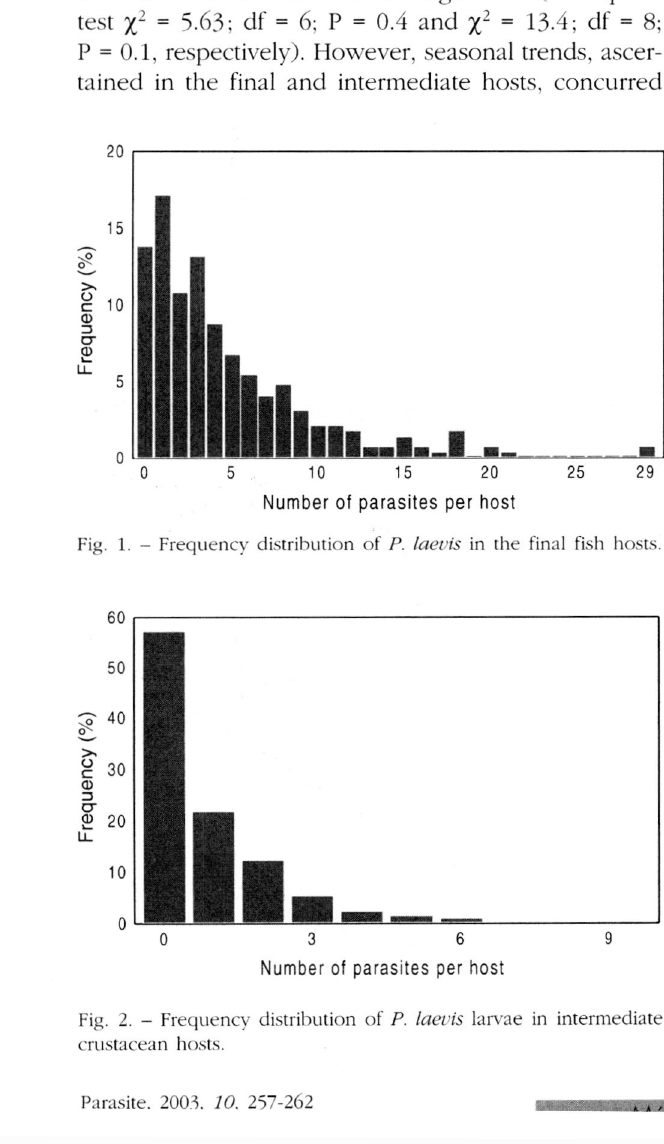
(Spearman rank order correlation r = 0.83; df = 4; P = 0.042). The highest relative numbers of adult